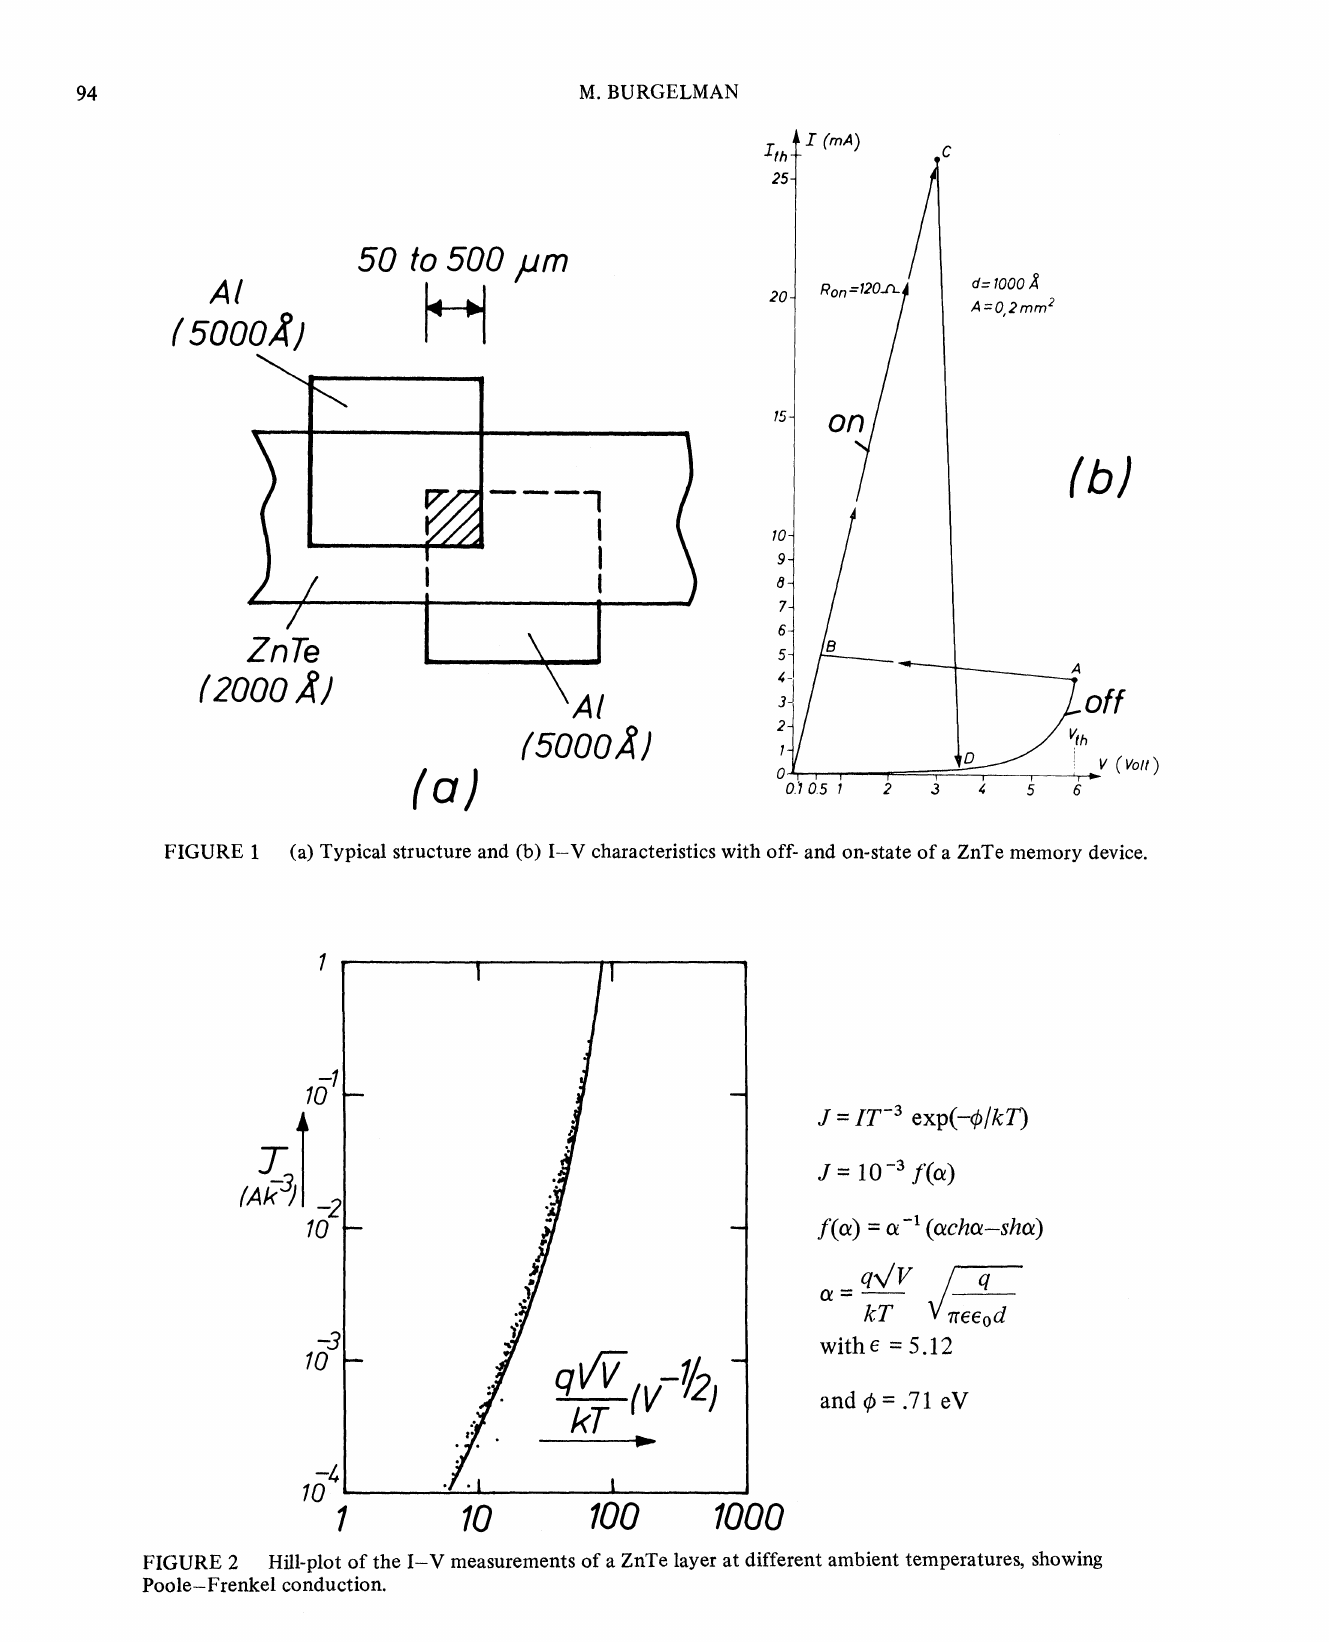
FIGURE 2 Hill-plot of the I-V measurements of a ZnTe layer at different ambient temperatures, showing Poole-Frenkel